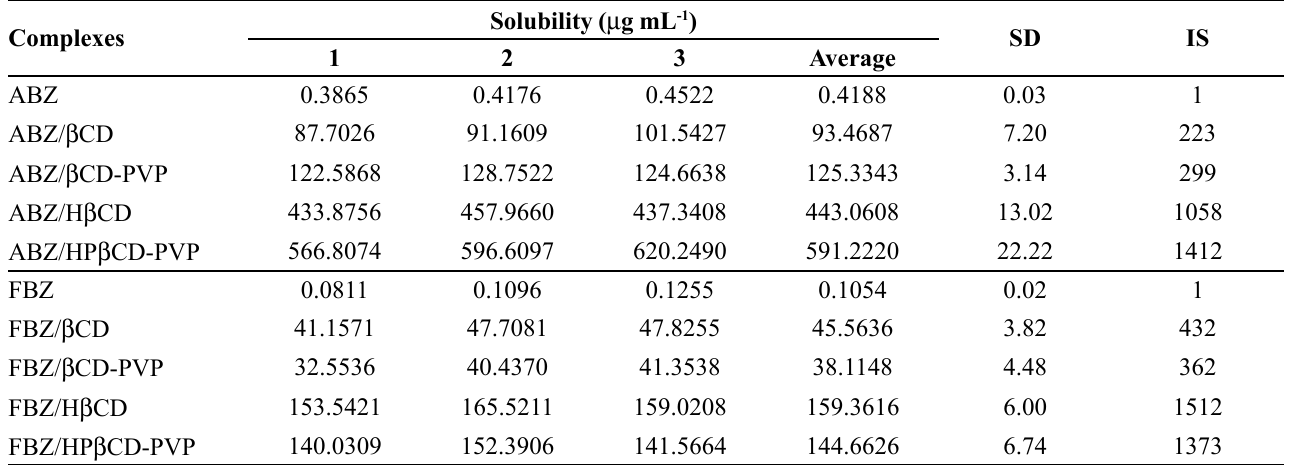
*SD, standard deviation; IS, increase of solubility (expressed in number of times)